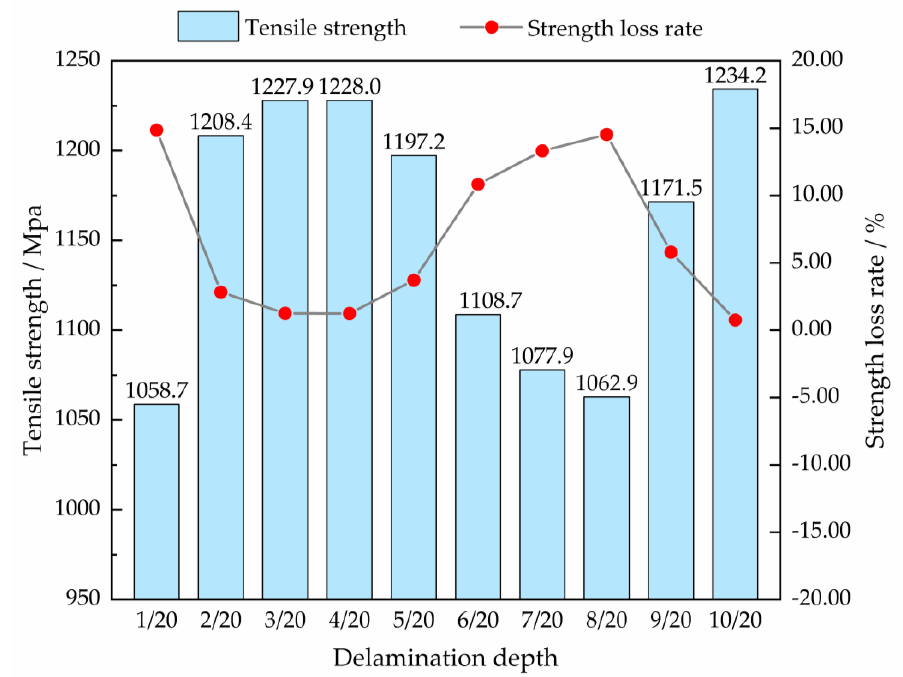
Figure 15. Influence of delamination depth on residual strength.